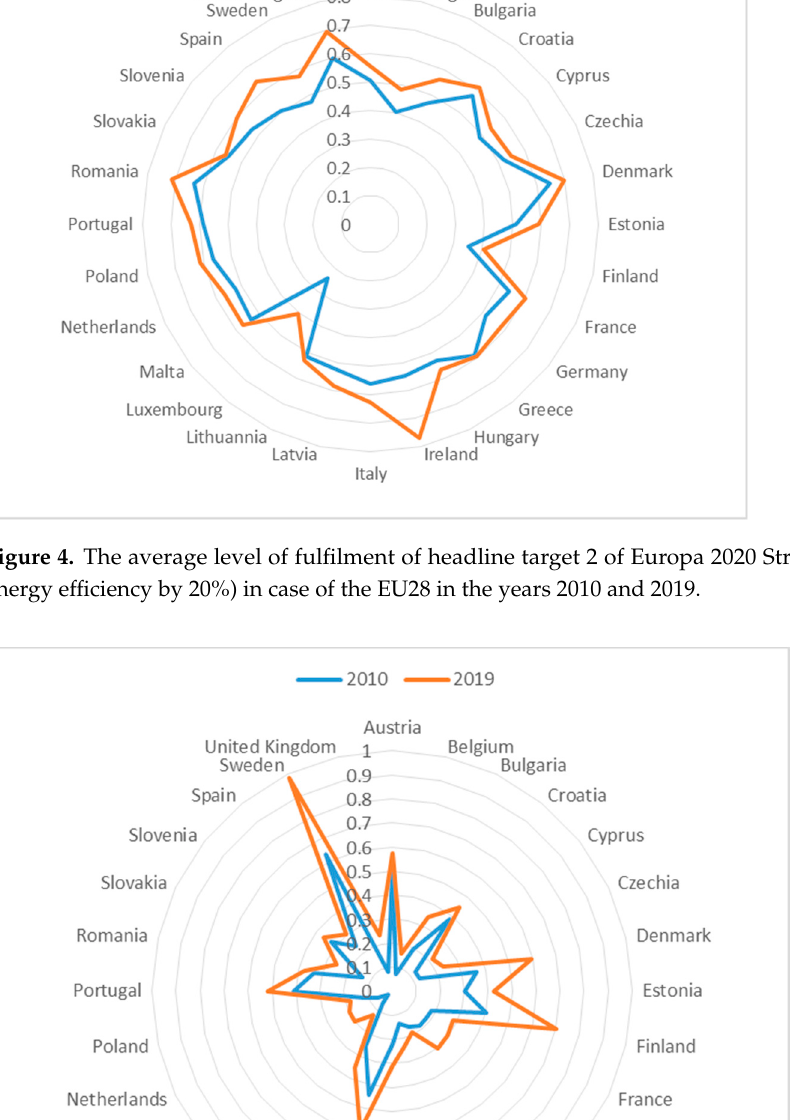
Figure 3. The average level of fulfilment of headline target 1 of Europa 2020 Strategy (20% reduc- tion in greenhouse gas emissions compared to 1990, as much as 30% possible) in case of the EU28 in the years 2010 and 2019.